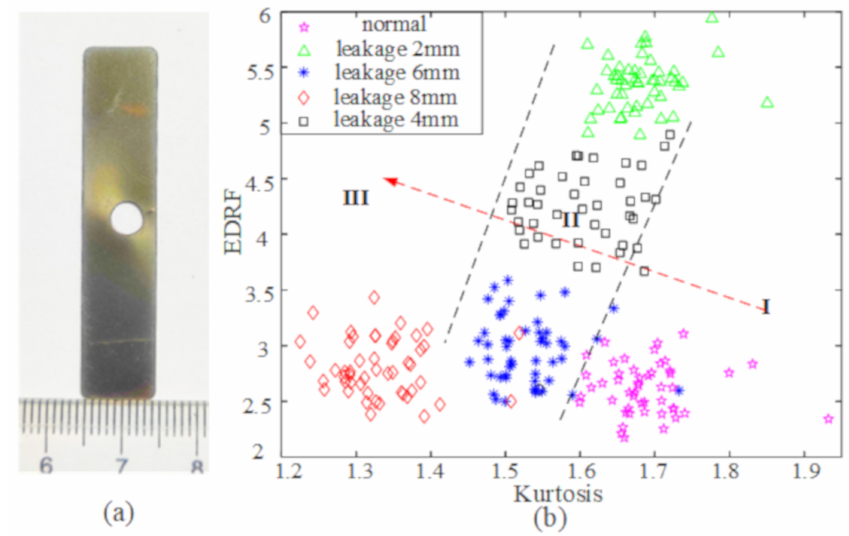
Figure 16. Diagnostic device verification; ( a ) 4 mm leakage valve, ( b ) fault diagnosis e ff ect of the valve based on the diagnostic device.